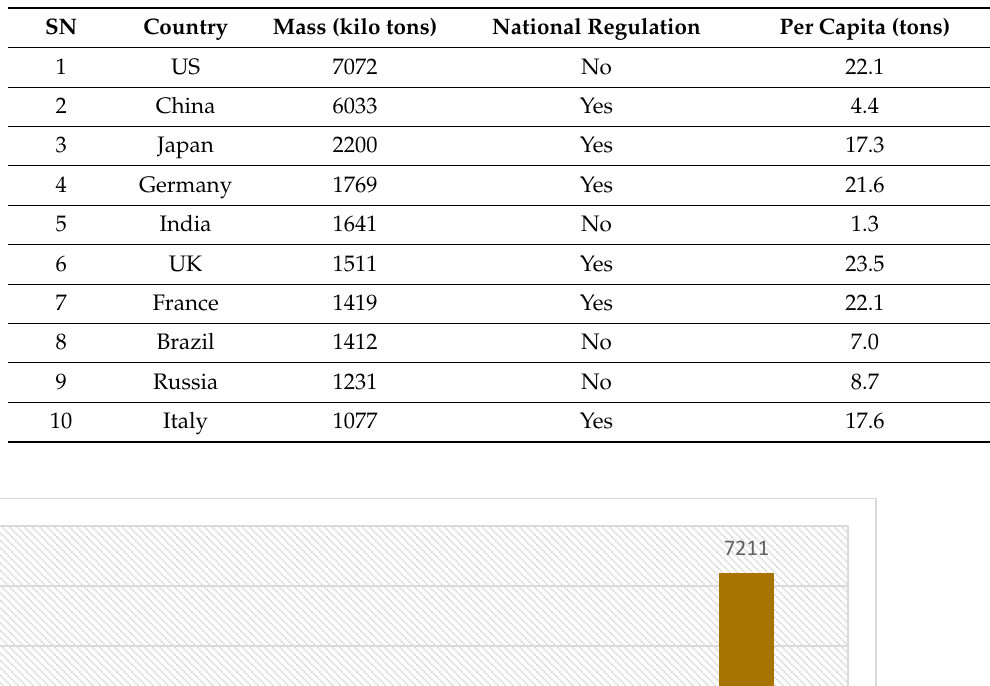
Table 1. Top ten global generators of WEEE, in total mass and per capita, and the presence of national regulations, 2014.